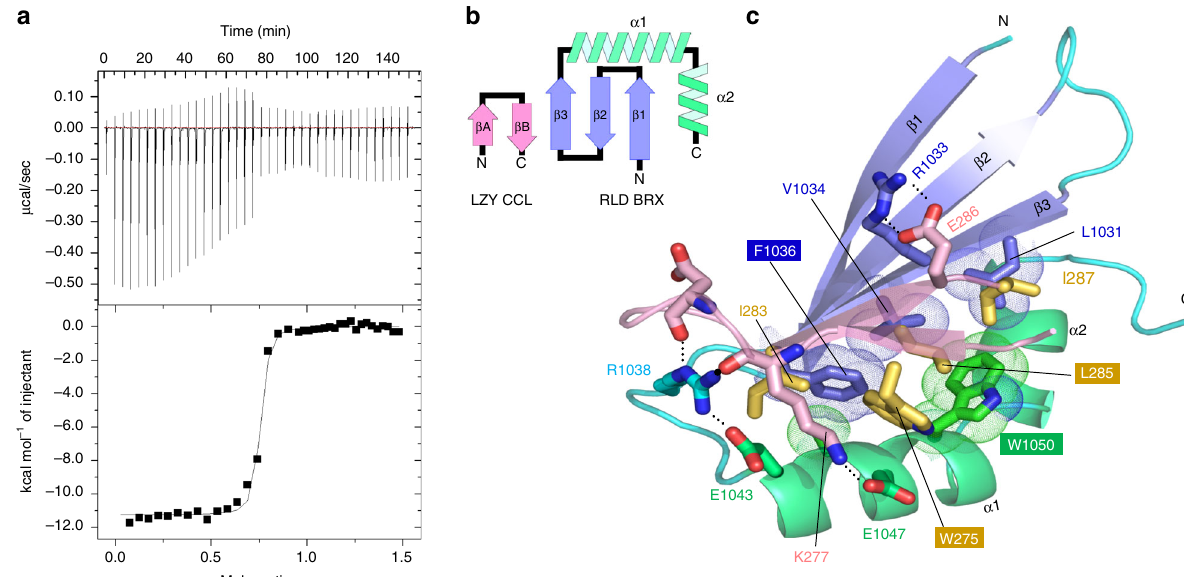
Fig. 4 The structure of the CCL-BRX complex. a Binding of the RLD2 BRX domain to the LZY3 CCL peptide. The obtained ITC pro fi le showed formation of a 1:1 complex with a small K D value (9.7 ± 2.2 nM). Δ H , T Δ S , and N are − 11.3 ± 0.09 kcal/mol, − 1.68 kcal/mol, and 0.73 ± 0.002, respectively. b Topology diagram of the RLD2 BRX domain bound to LZY3 CCL. c Ribbon representation of the crystal structure of the BRX-CCL complex. Color codes are as in b . The RLD2 BRX domain comprises a three-stranded antiparallel β -sheet (blue) and two α -helices (green). The LZY3 CCL peptide adopts a β -hairpin structure (pink). Dashed lines represent inter-molecular hydrogen bonds. The colors of corresponding positions in the CCL-BRX complex at which mutations were introduced in RLD1-GFP and LZY3-mCherry are